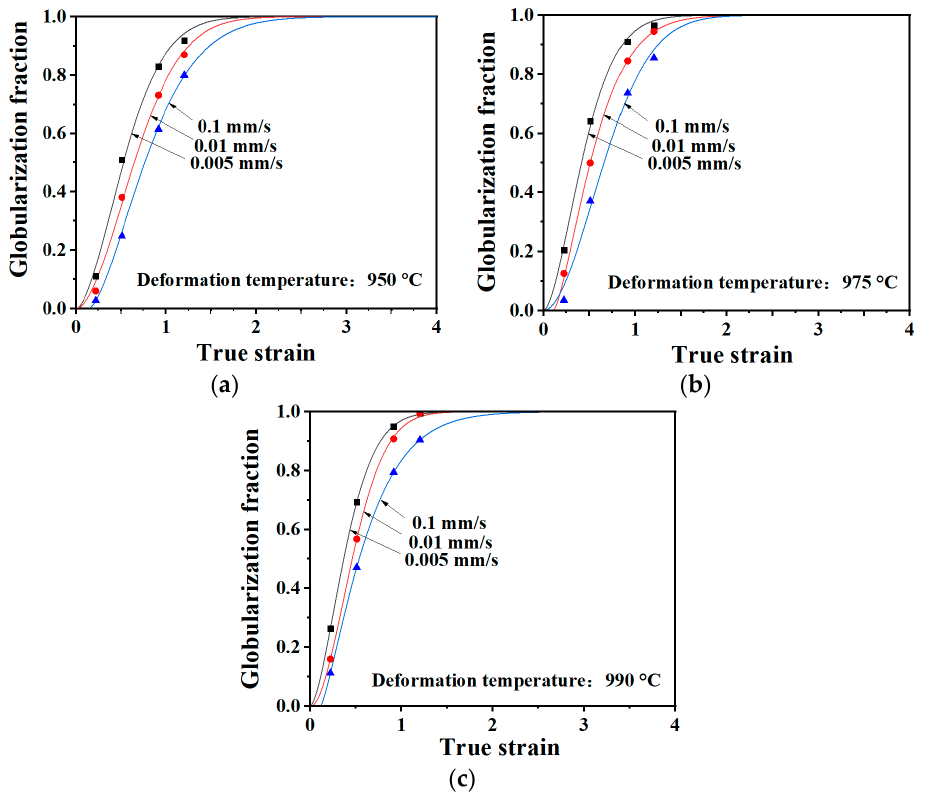
Figure 6. Theoretical dynamic globularization curves under: ( a ) 950 °C; ( b ) 975 °C; and ( c ) 990 °C.